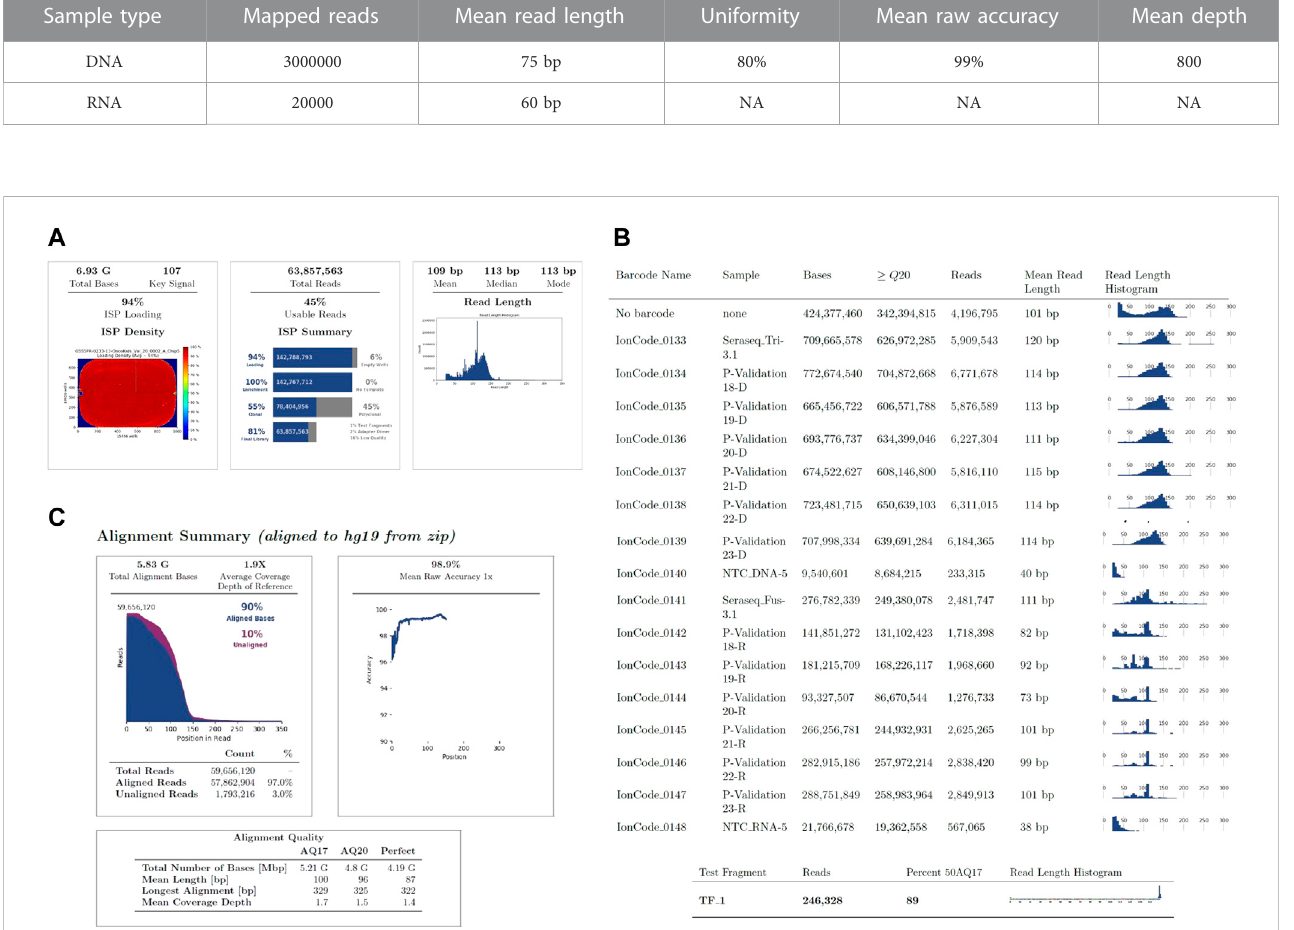
FIGURE 1 Run Summary Metrics obtained post sequencing. (A) . Summary of metrics across the chip with loading density which is expected to be at ≥ 85% (left panel), total number ofreadsbeing ≥ 60M and usable readsbeing ≥ 35% (middle panel) andtheaverage readlength evaluated (right panel). (B) .Run metrics for each sample on the chip. (C) . Sequence alignment